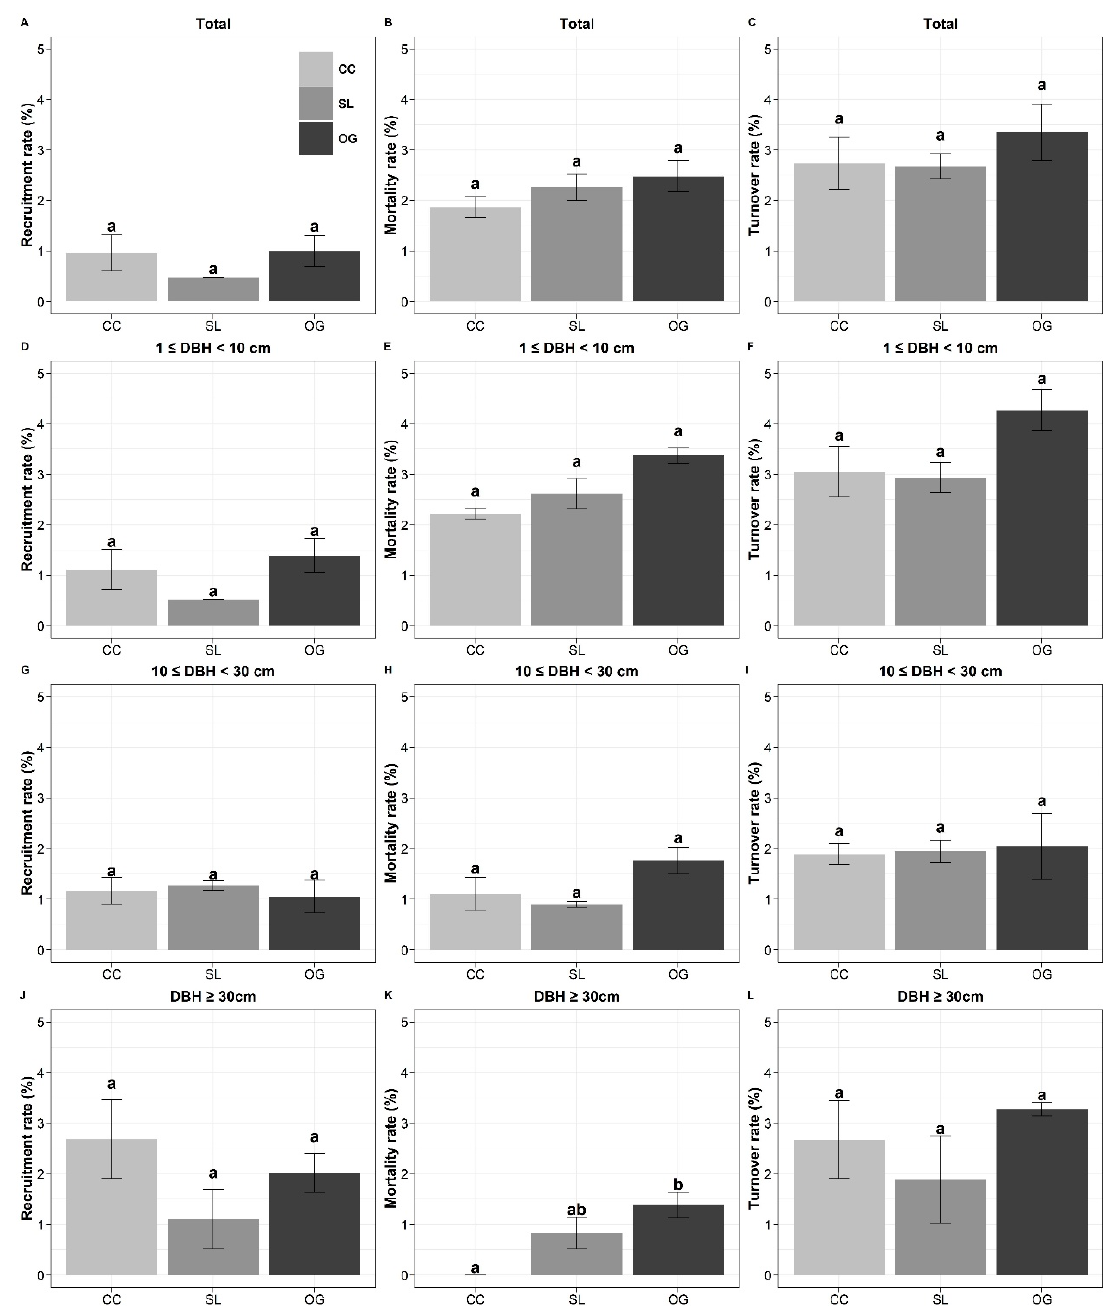
Figure 3. Recruitment, mortality and turnover rates of food plant abundance among forests after three disturbances (clear-cutting, CC; selectively logged, SL; old growth forests, OG) for all individuals ( A – C ), small trees (1 cm ≤ DBH < 10 cm, D – F ), medium trees (10 cm ≤ DBH < 30 cm, G – I ) and large trees (DBH ≥ 30 cm, J – L ). DBH, diameter at breast height. Different lowercase letters indicated significant differences between three disturbances at p < 0.05 according to ANOVA and HSD test.